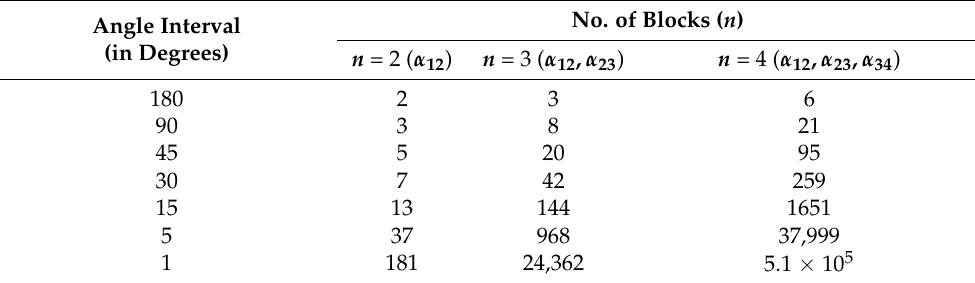
Table 1. Number of unique morphologies based on the number of block and angle interval. Angle